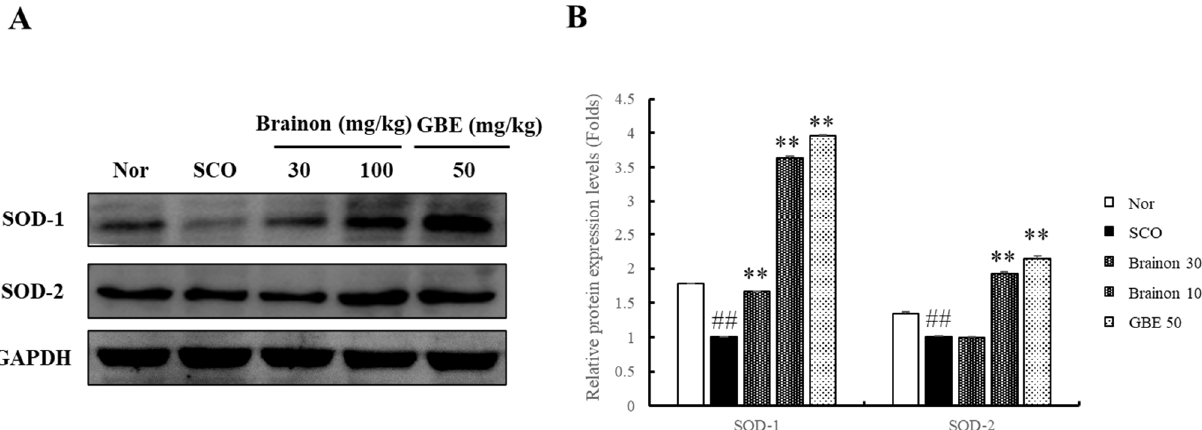
Figure 6. Effects of Brainon on anti-oxidant related protein levels in the hippocampal tissues of memory deficit mice. ( A ) Superoxide dismutase (SOD)-1, and SOD-2 protein expression were evaluated via western blotting. ( B ) The protein band density was measured utilizing by the software. Protein was normalized using the GAPDH. Values are represented as means ± SEM ( n = 3). ## p < 0.01 vs. Normal group; ** p < 0.01 vs. SCO-treated group.